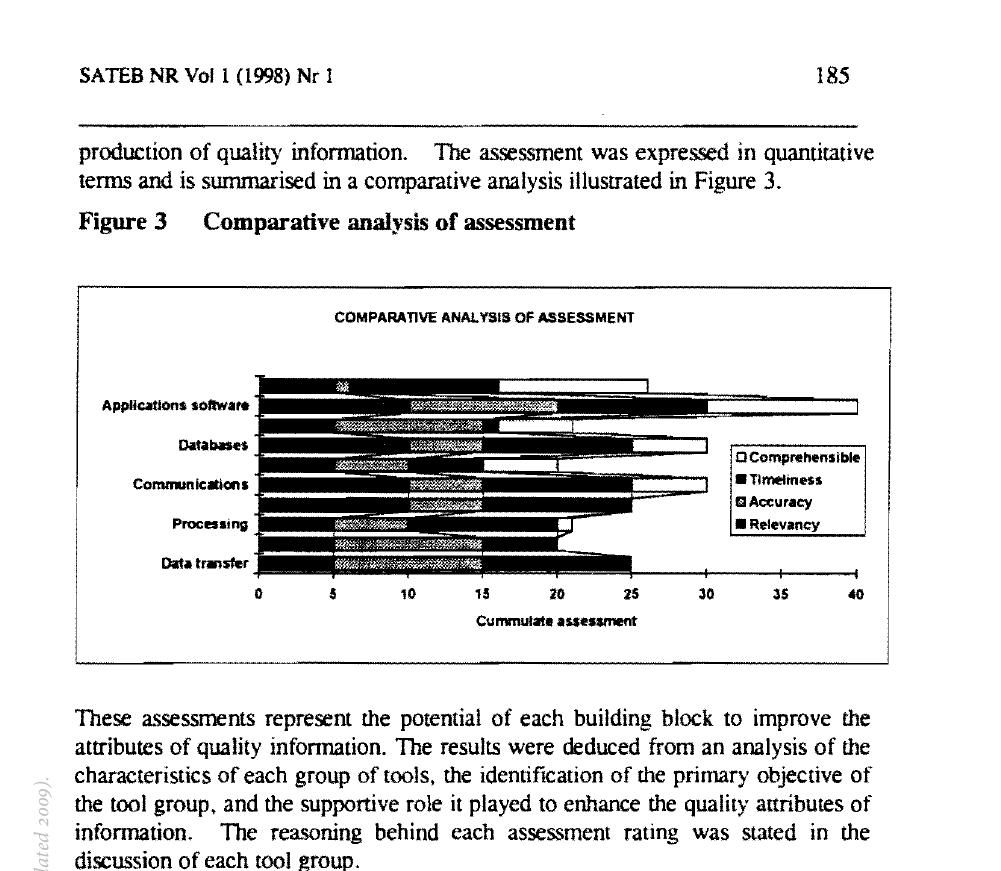
Comparative analysis of assessment